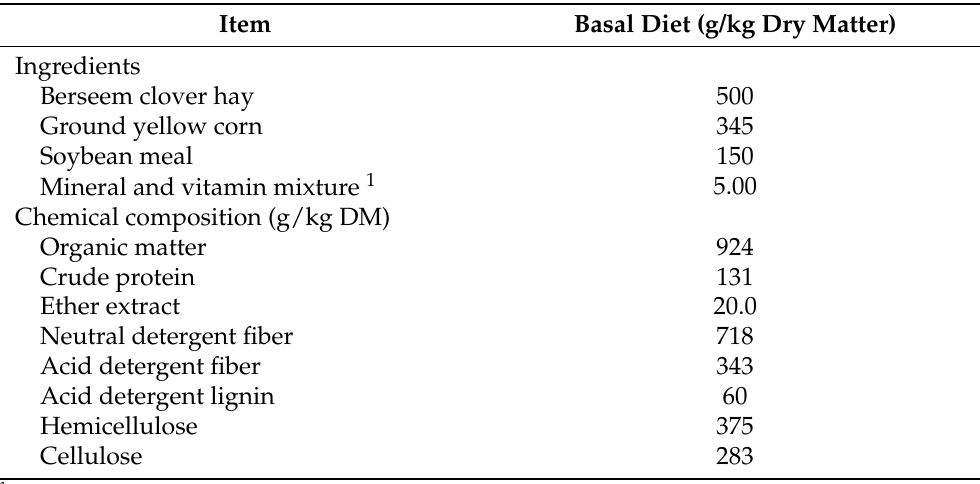
Table 2. Ingredients and chemical composition of experimental basal diet used in the in vitro and in vivo